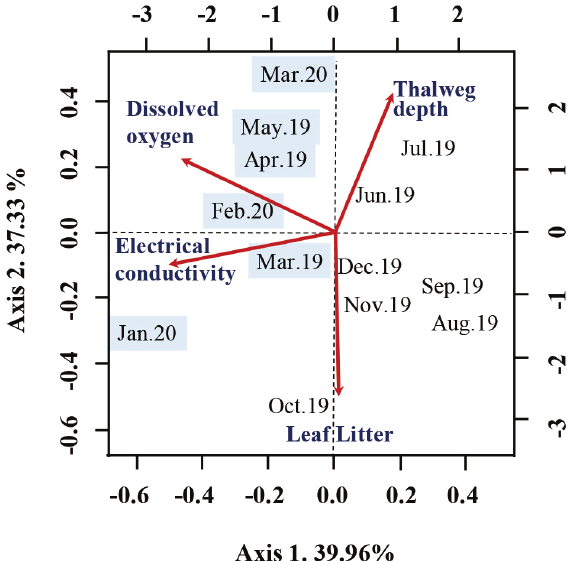
FIGURE 6 | Ordination of the 13 monthly samples collected in a catchment of the Guamá River, in the municipality of Capitão Poço, Pará State, Brazil, between March 2019 and March 2020. The months with a blue background represent the rainy season.